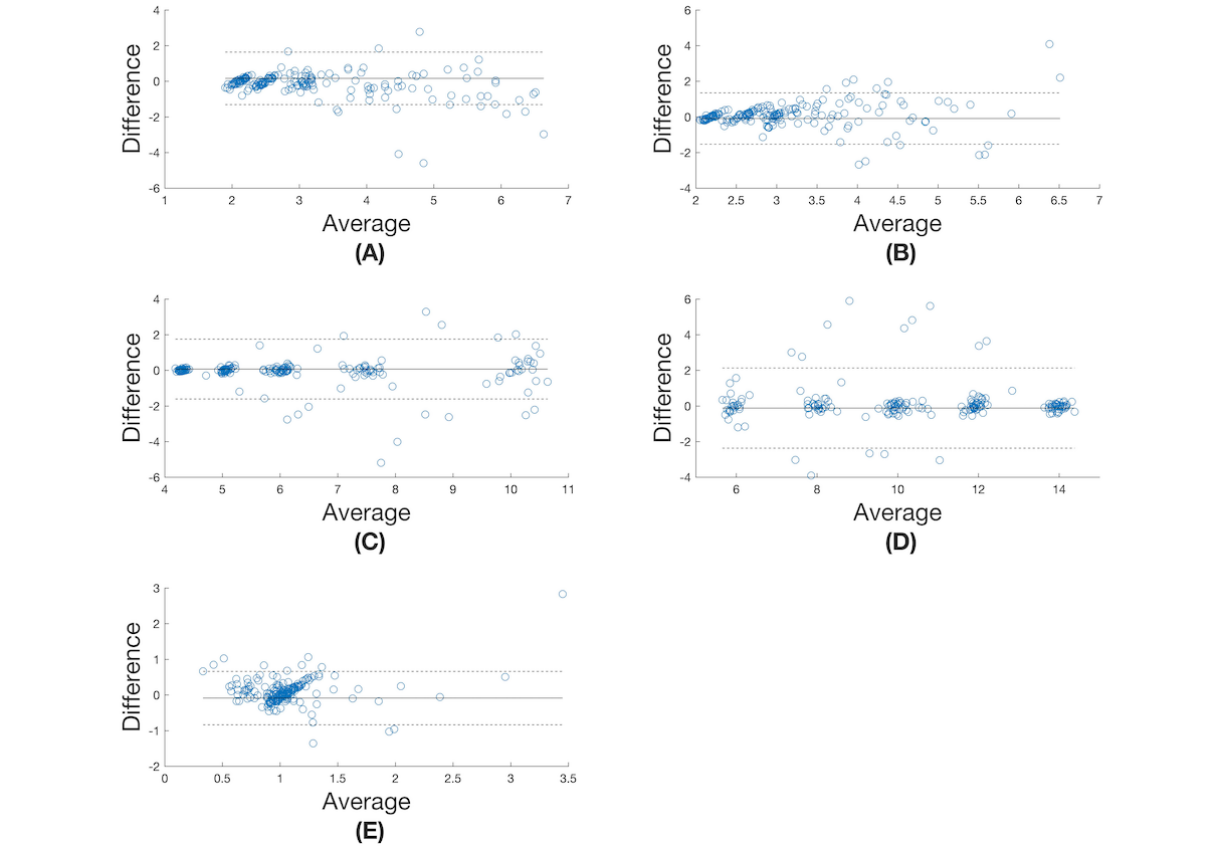
Figure 4. Bland-Altman plots for (A) inspiration time (seconds), (B) expiration time (seconds), (C) interbreath interval (seconds), (D) breathing rate (breaths per minute), and (E) inspiration:expiration ratio using the LSTM